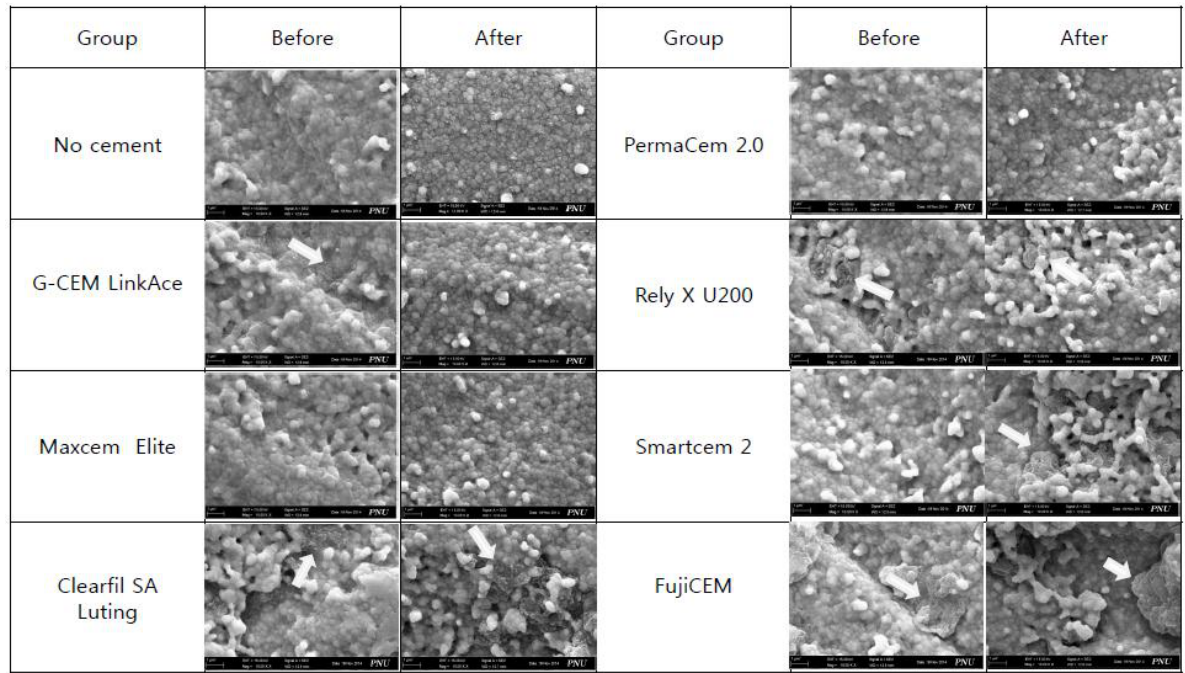
Figure 1. Field-emission scanning microscope images of the fractured zirconia surface before and after thermocycling. The white arrows represent the cements on the zirconia surface and those means that they showed cohesive failure. (magnification: